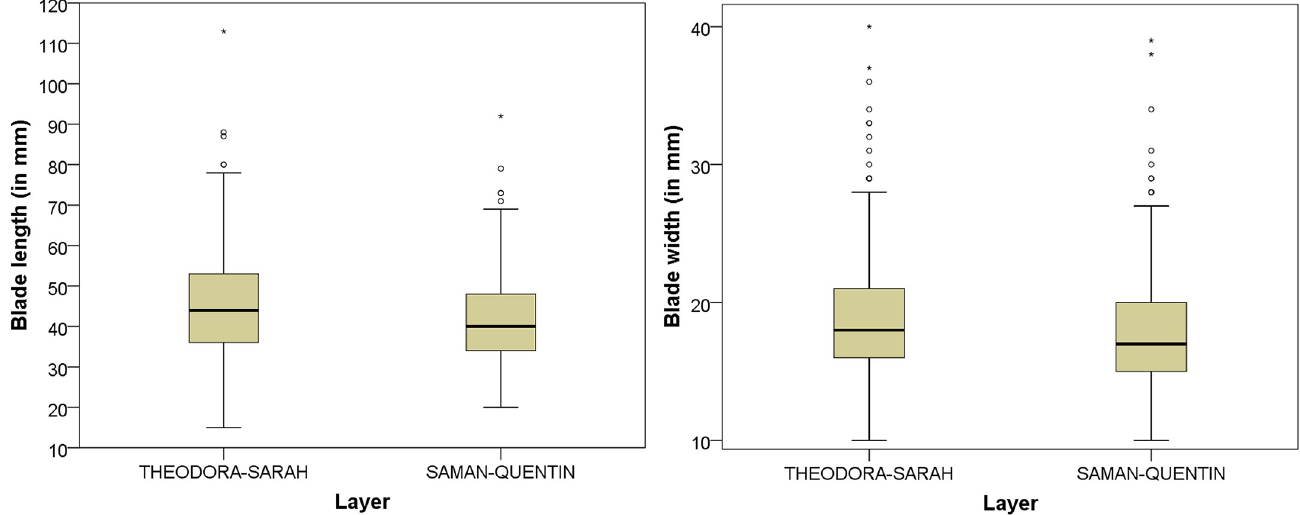
Fig 4. Box plot for length and width of blades between layers THEODORA-SARAH and